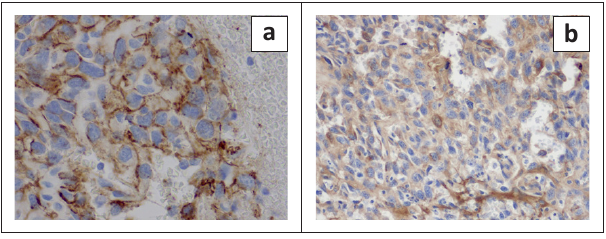
FIGURE 4: Photomicrographs of the mass of the os penis (200 x magnification), (a) Neoplastic cells labelled with CD31 monoclonal antibody showing positive cytoplasmic granular labelling. The cells line the cavernous spaces and (b) labelled with polyclonal Factor VIII antibody also showing positive cytoplasmic granular labelling on